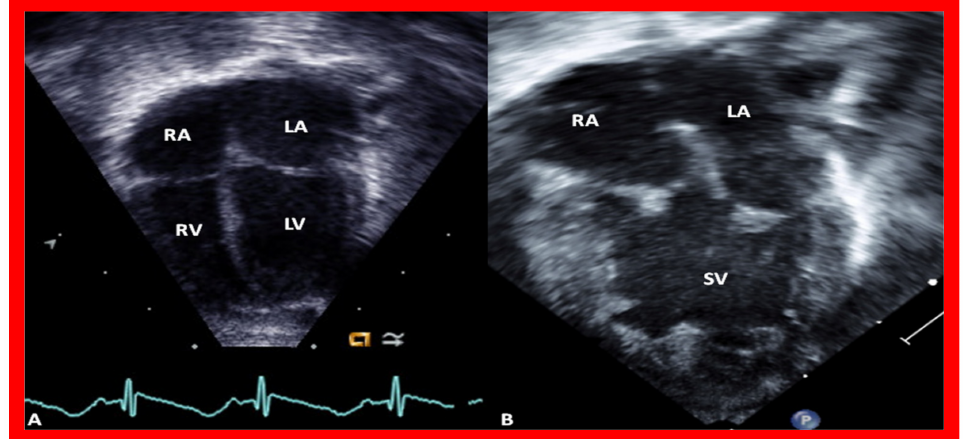
Figure 2. The 2D echo images from apical four-chamber projections of two children, one with two ventricles ( A ) and another with a single ventricle (SV) ( B ). These figures were prepared after the American Society of Echocardiography recommendations of the current way in which we display the images. Left atrium (LA), left ventricle (LV), right atrium (RA), and right ventricle (RV) are marked. Reproduced from Reference